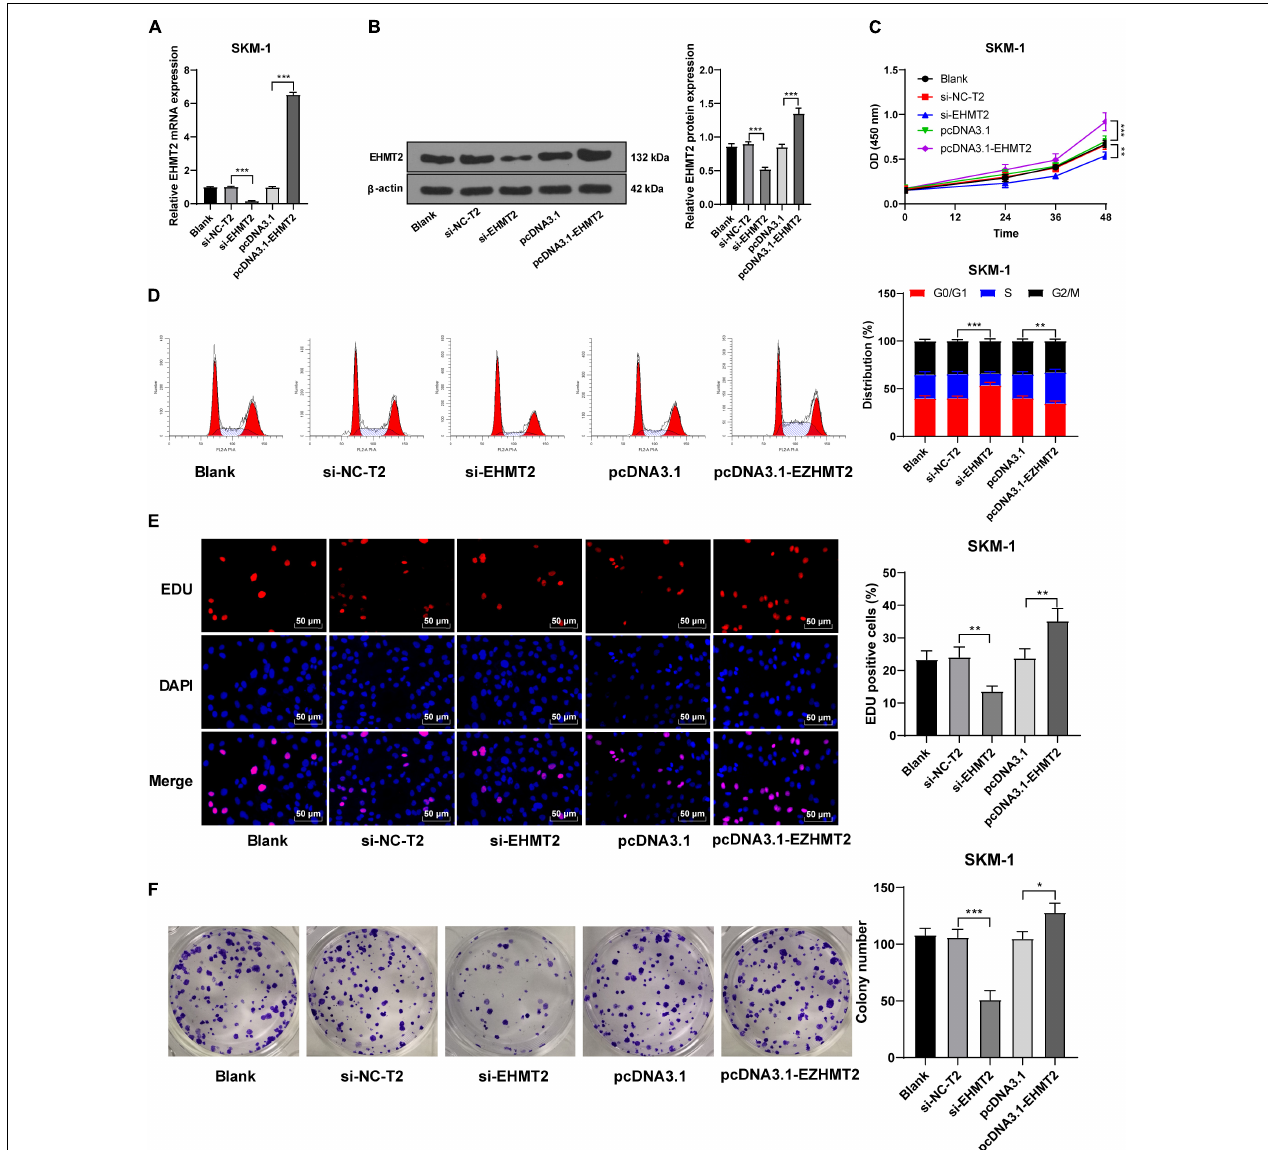
FIGURE 4 | Silencing EHMT2 expression inhibited SKM-1 cell proliferation. (A,B) Transfection efficiency of si-EHMT2 or overexpression of EHMT2 was confirmed using RT-qPCR and Western blot; (C) Viability of SKM-1 cells under different treatments was measured using CCK-8 assay; (D) Cell cycle of SKM-1 cells was detected using flow cytometry; (E,F) Proliferation ability of SKM-1 cells was measured using EdU and colony formation assay. The cell experiments were repeated three times. Data are expressed as mean ± standard deviation. Data were analyzed using one-way ANOVA, followed by Tukey’s multiple comparisons test, * p < 0.05, ** p < 0.01, *** p <